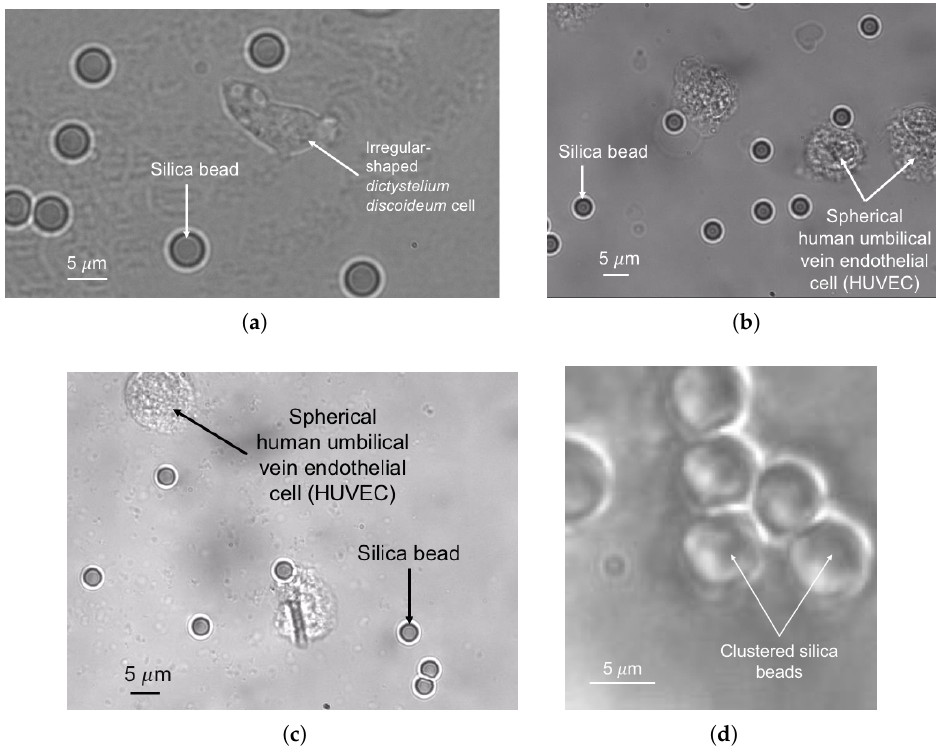
Figure 2. Example images of cells and microspheres in different fluid media: ( a ) amoeba cell and silica ( x , y ) ; ( b ) human endothelial cells and silica beads in water, I sw beads in water, I iw j endothelial cells and silica beads in Matrigel, I sm ( x , y ) Matrigel, I cm j